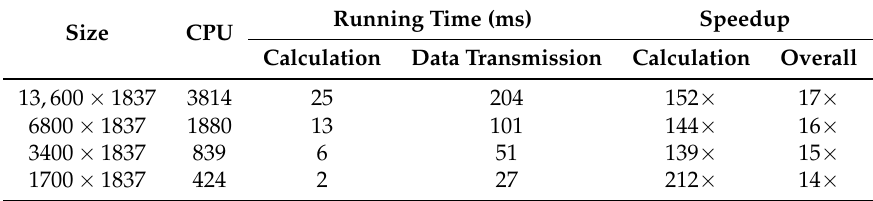
Table 2. Acceleration results of Dubois inversion.